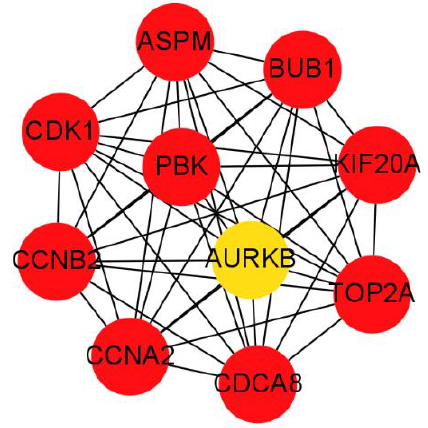
Figure 8. The top 10 genes with the highest value of MCC scores in the PPI network. (The closer the background color of the circle is to red, the higher the MCC score of the gene in the network, and the red is the highest score.).